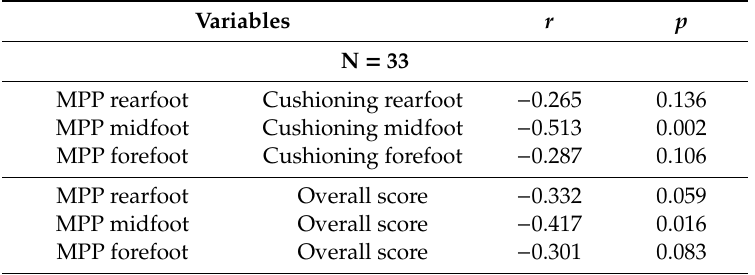
Table 2. Correlations between perceived maximum peak pressure (MPP) and